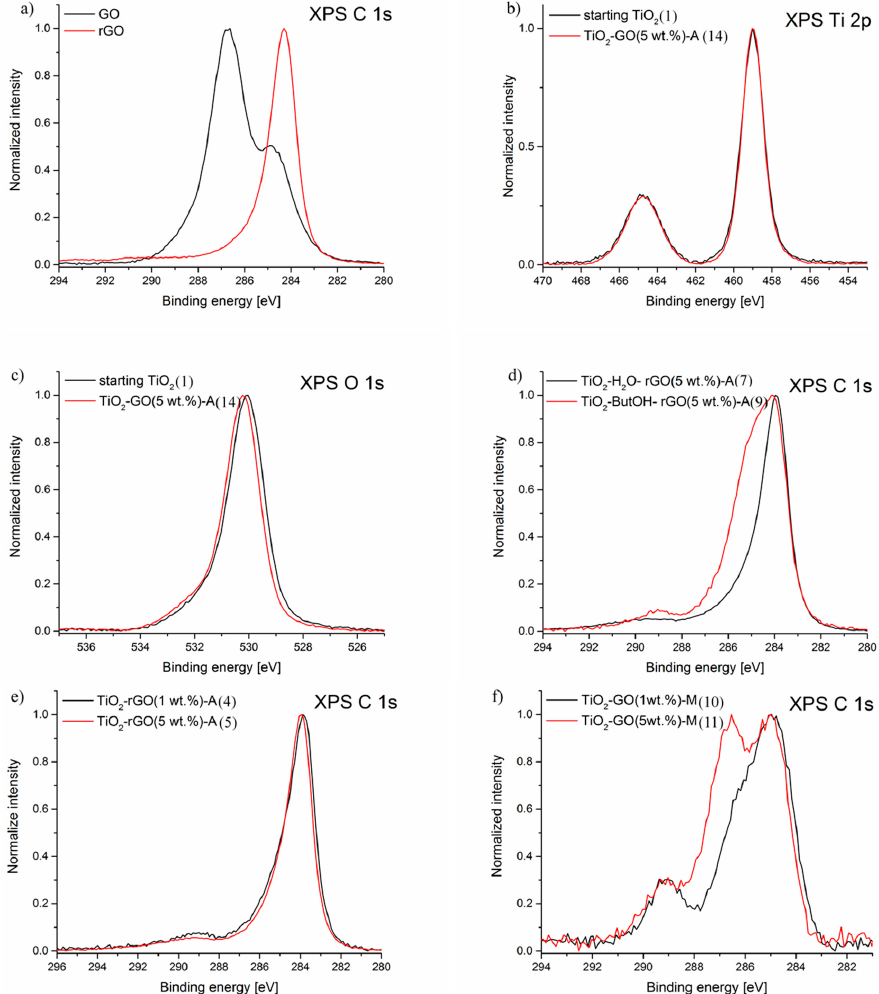
Figure 4. XPS spectra of: ( a ) Ti 2p line for starting TiO 2 sample and TiO 2 -GO(5 wt%)-A nanocomposite; ( b ) O 1s line for starting TiO 2 sample and TiO 2 -GO(5 wt%)-A nanocomposite; ( c ) C 1s line for graphene oxide (GO) and reduced graphene oxide (rGO); ( d ) C 1s line for TiO 2 -rGO composites with different solvents used; ( e ) C 1s line for samples TiO 2 -rGO treated in autoclave with different concentrations of rGO; and the ( f ) C 1s line for samples TiO 2 -GO mixed manually with different concentrations of GO.